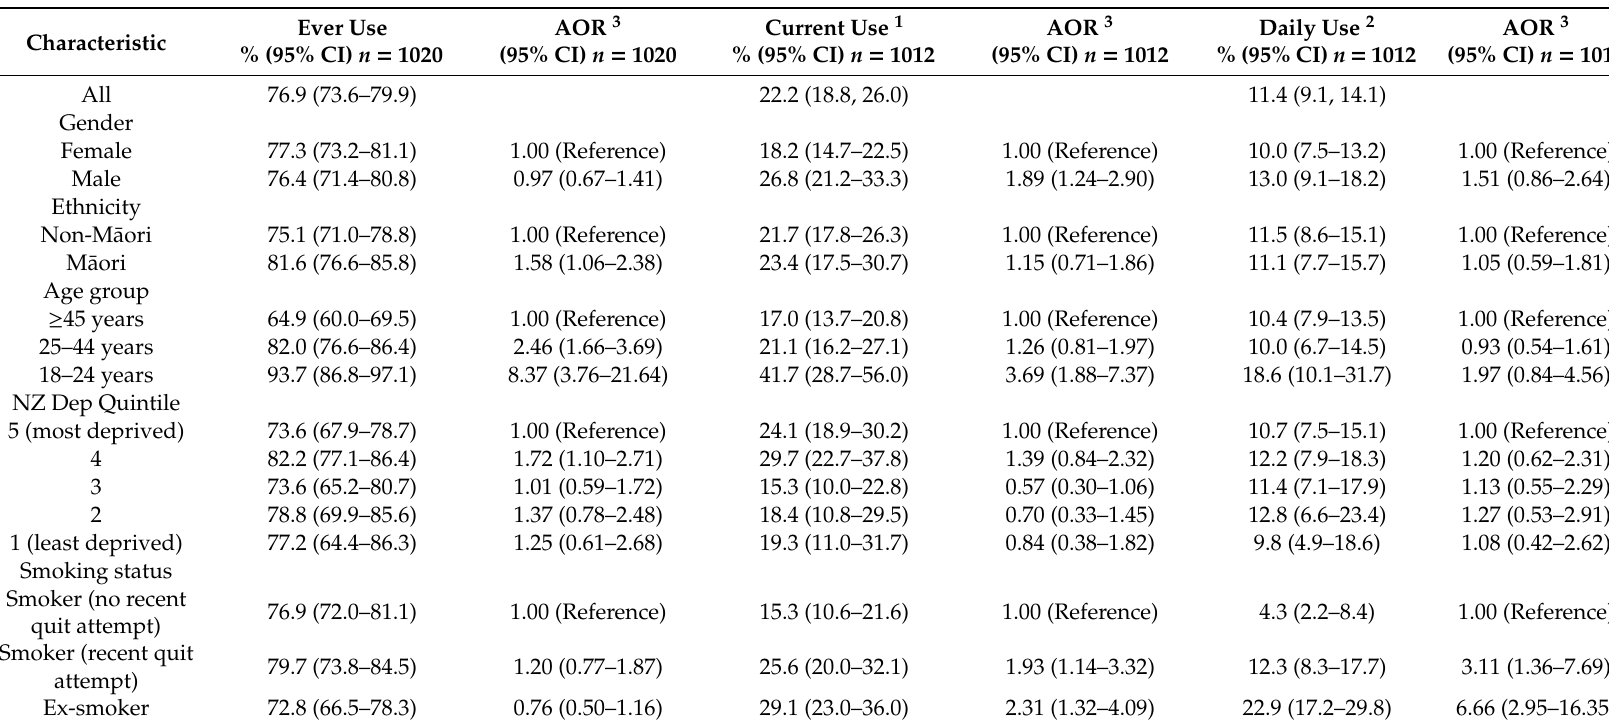
Table 3. Trial and use of e-cigarettes in Wave 2: stratified estimates and associations with gender, ethnicity, age group, socio-economic status, and smoking status.